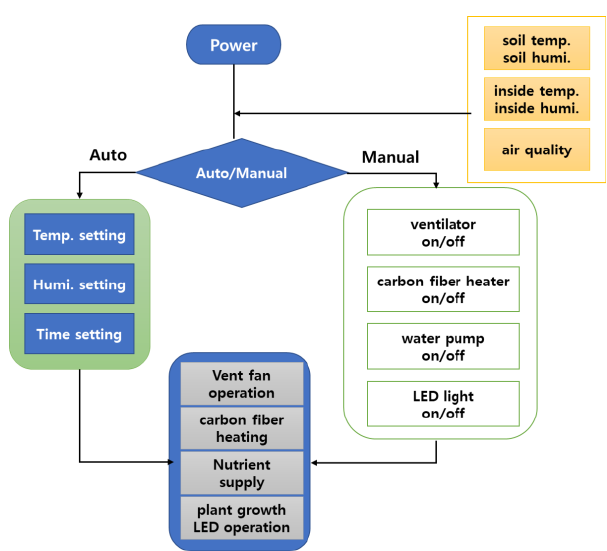
Figure 12. Flow chart of the control program.